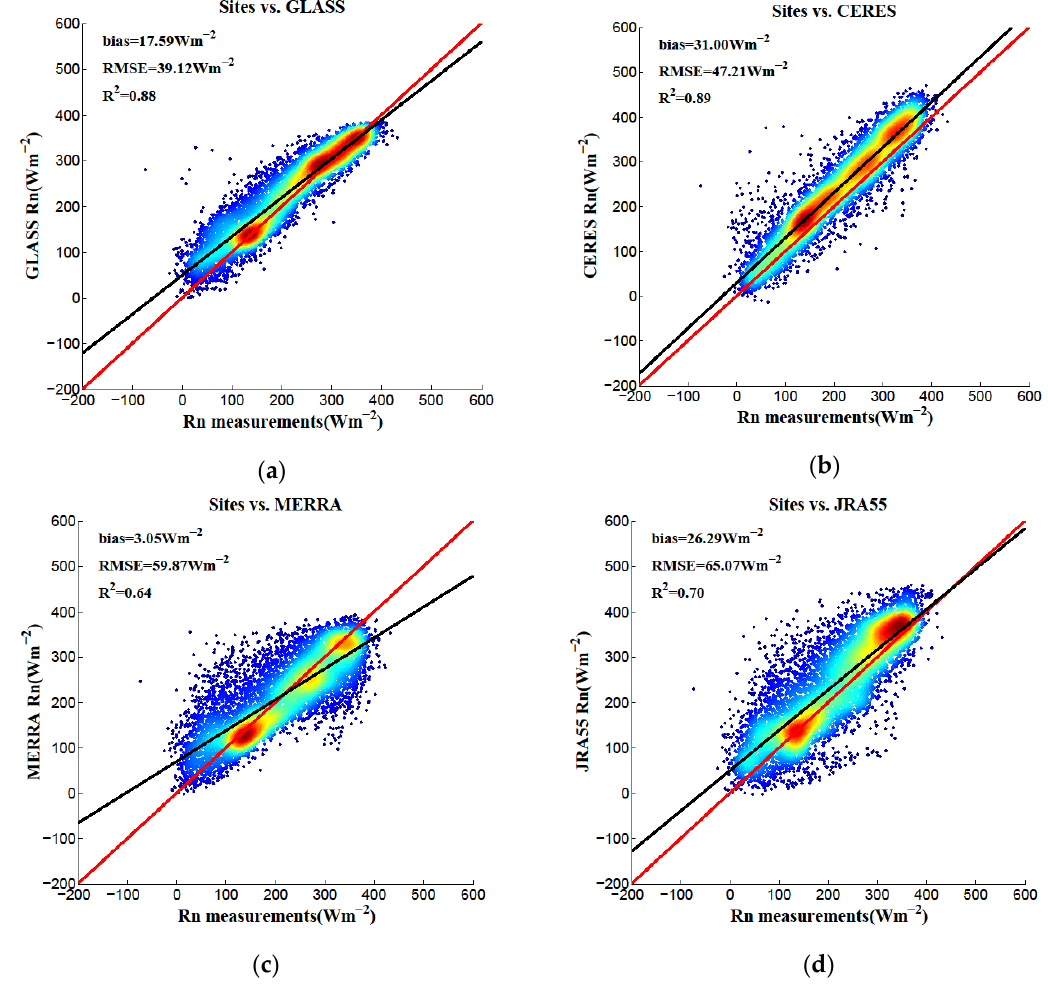
Figure 5. Scatterplots of the four daytime R n products (GLASS ( a ); CERES-SYN ( b ); MERRA ( c ); and JRA55 ( d ) against the in situ measurements.